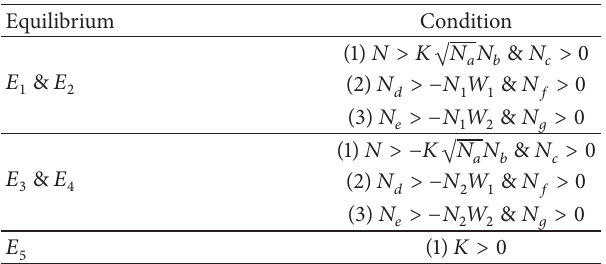
Table 2: Conditions for a nonnegative